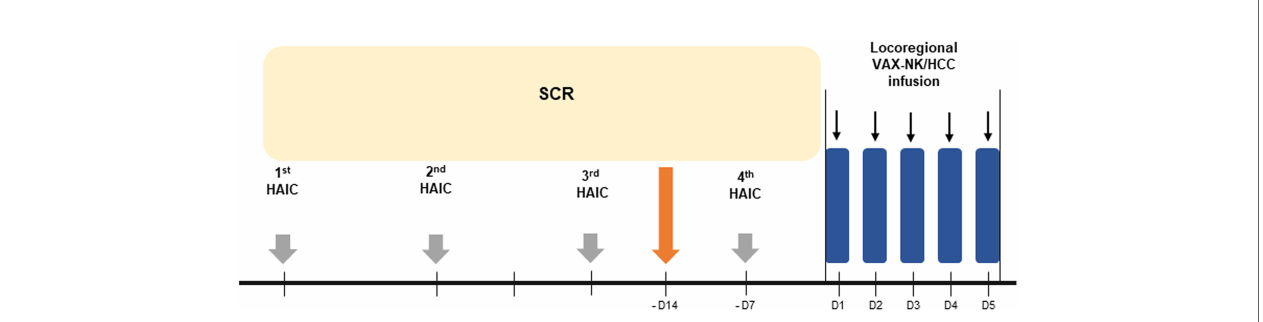
FIGURE 1 | The schematic scheme for the treatment schedule of VAX-NK/HCC infusion following HAIC treatment. HAIC, hepatic arterial infusion chemotherapy; NK, natural killer;